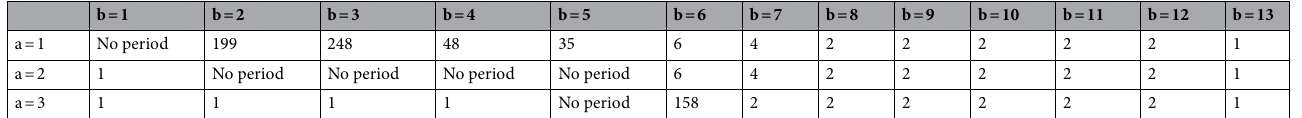
Table 3. Temporal emergence of periodic behavior in the brain connectome.